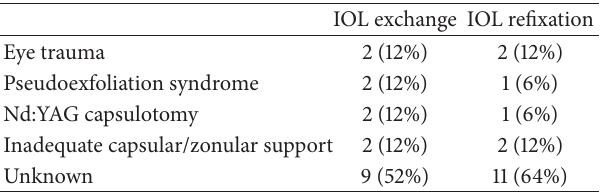
Table 2: Presumed causes of IOL dislocation.